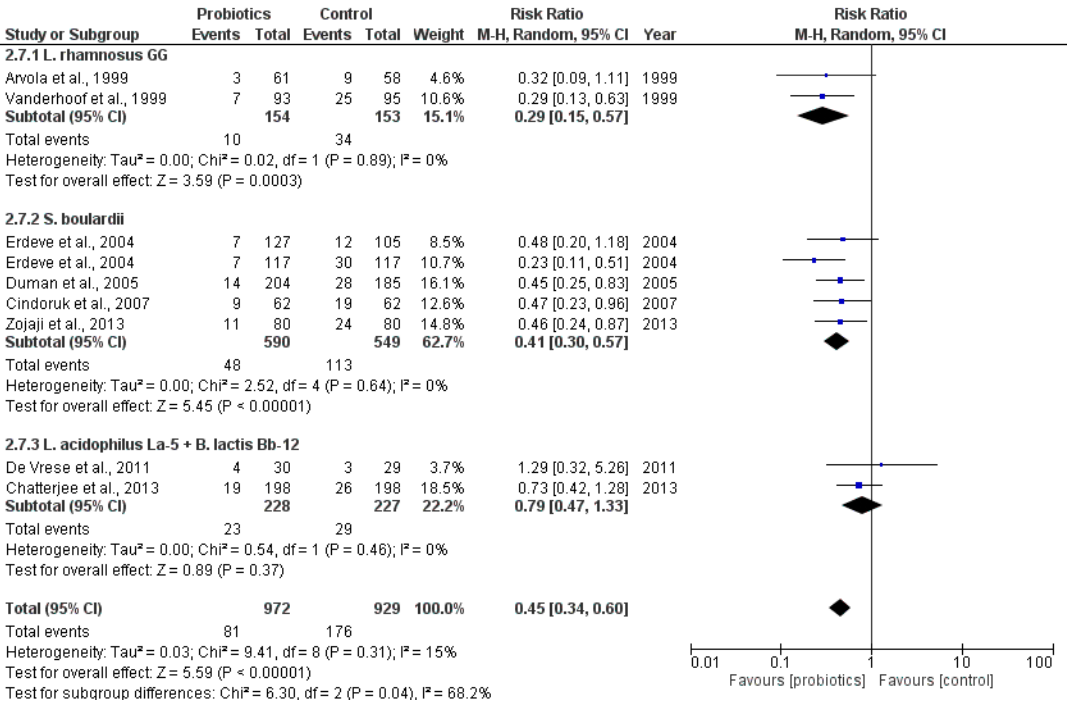
Figure 3. Efficacy results of probiotic use: eight RCTs by three probiotic subgroups (outcome: incidence of antibiotic-associated diarrhea (AAD)).